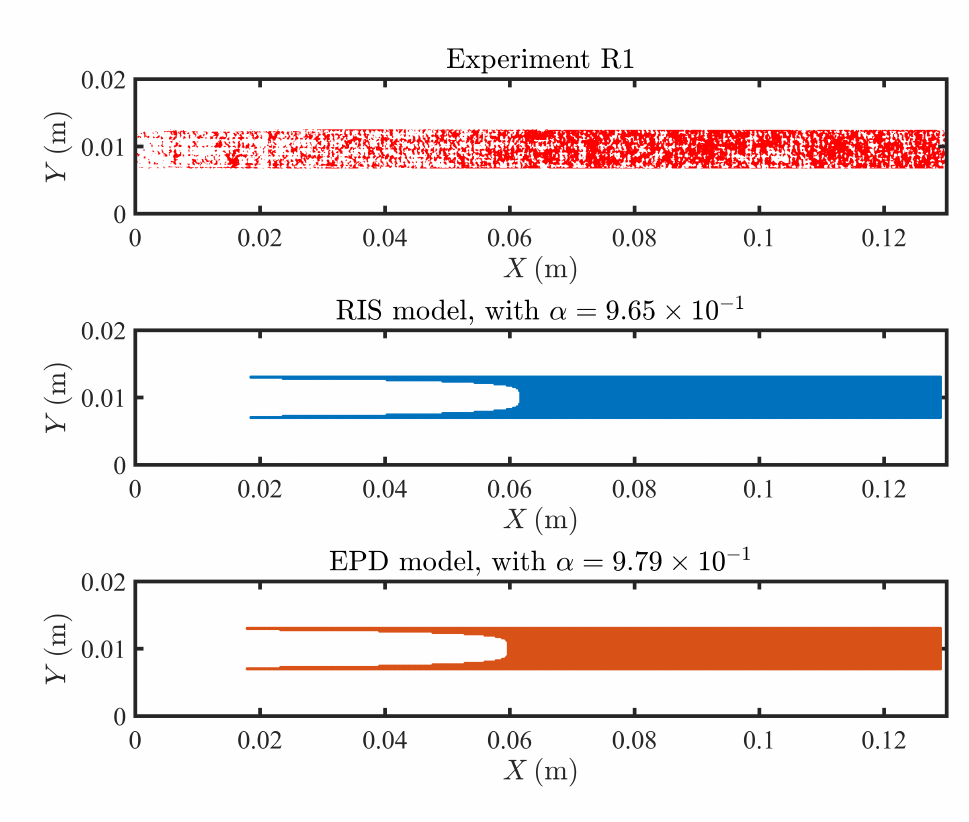
Figure 7. Comparison of the fouling pattern of R1, between the experimental results (in red), the RIS model simulation results (in blue) and the EPD model (in